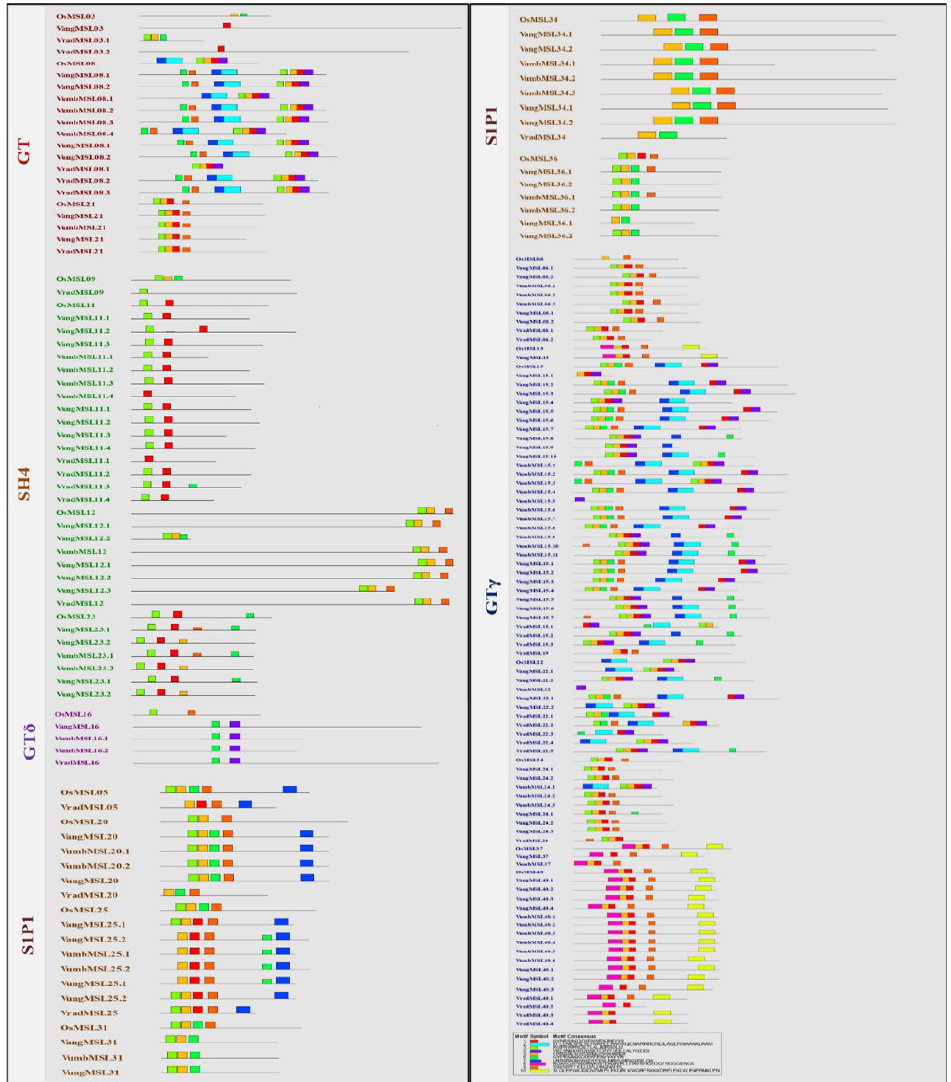
Figure 3 . The conserved motif of trihelix family genes in Vigna species along with its rice orthologs. The different color box represents the different 10 motifs. Vung, V. unguiculata; Vrad, V. radiata; Vang, V. angularis; Vumb, V. umbellata; Os, Oryza sativa. MSL, Myb/SANT-LIKE.